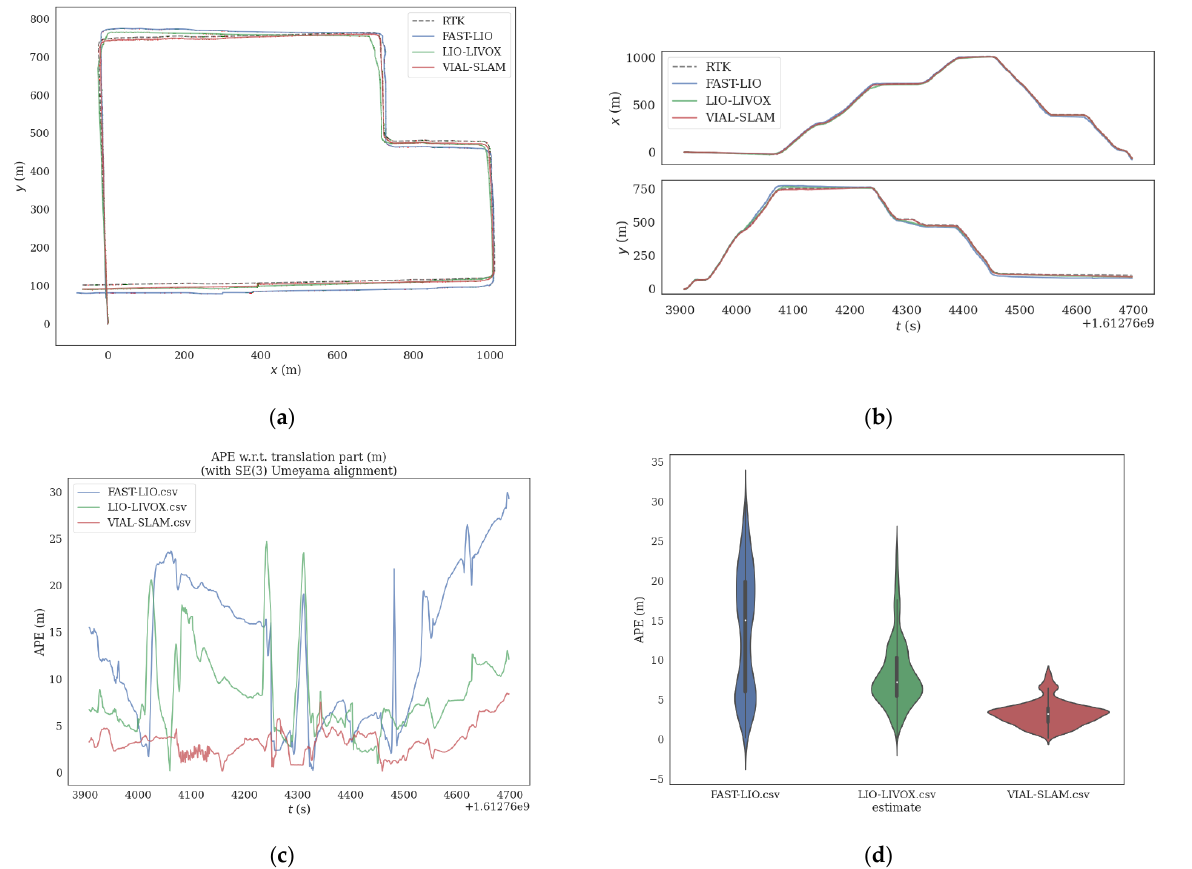
Figure 12. Error analysis diagram. ( a ) Trajectory comparison; ( b ) trajectory comparison on the x -axis and y -axis; ( c ) error comparison; ( d ) error estimate. Table 2. The autonomous positioning test results in the urban road environment.